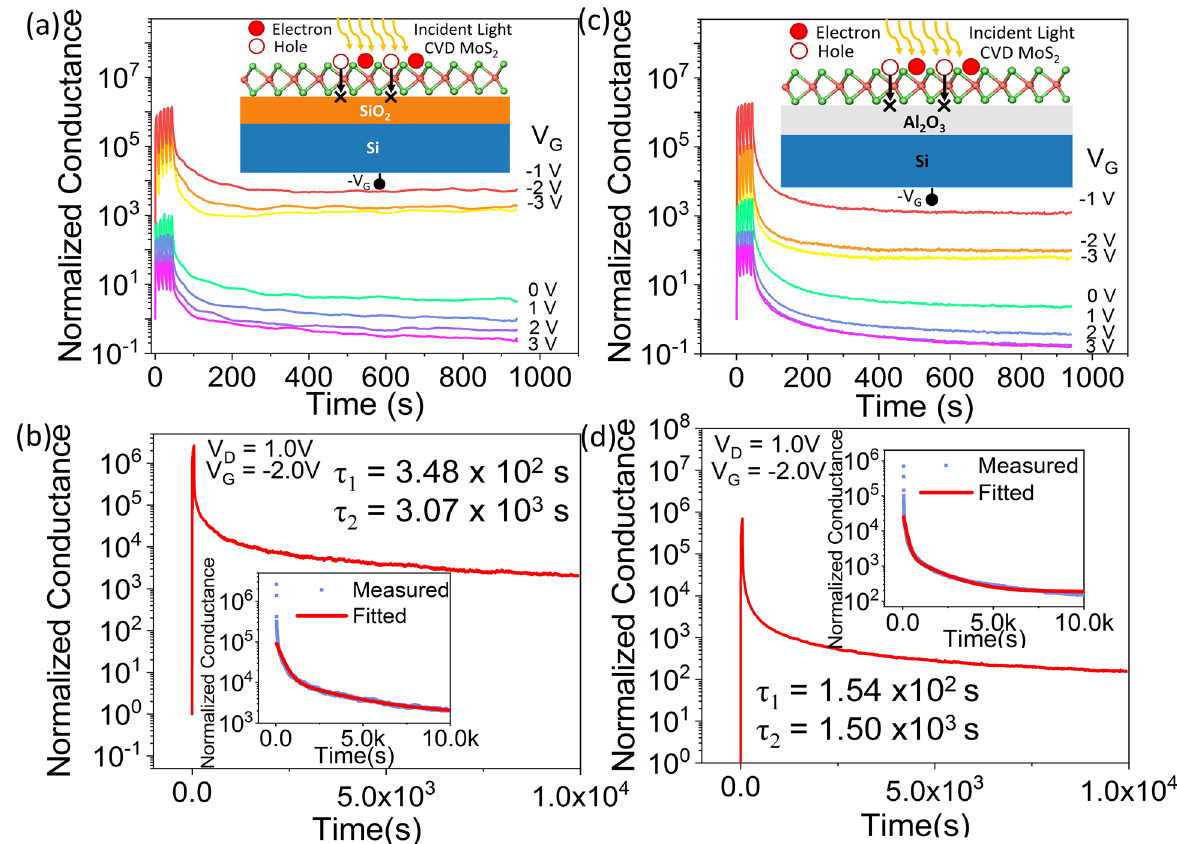
Figure 2. CVD grown monolayer MoS 2 on SiO 2 gate: ( a ) Gate-tunable potentiation and conductance retention. ( b ) Retention for 10 4 s, after applying 5 light pulses. Inset shows the retention curve fitted with an exponential decay function. CVD grown monolayer MoS 2 on Al 2 O 3 gate: ( c ) Gate-tunable potentiation and conductance retention. ( d ) Retention for 10 4 s, after applying 5 light pulses (5 s on/5 s off). Inset shows the retention curve fitted with an exponential decay